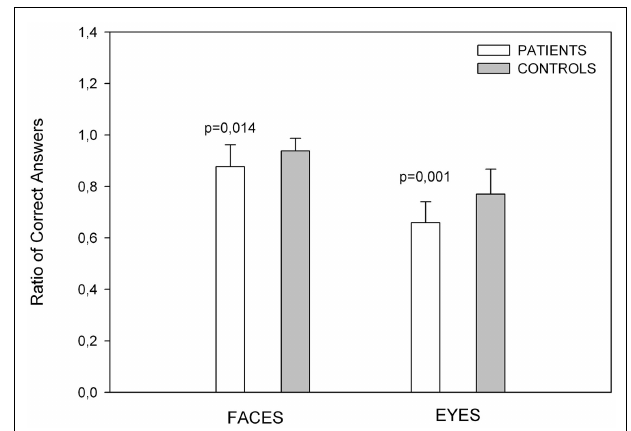
FIGURE 1 | Showing emotion recognition scores . Control subjects had better results than patients in recognition of emotion in faces and eyes. Error bars depict standard deviations in all figures.